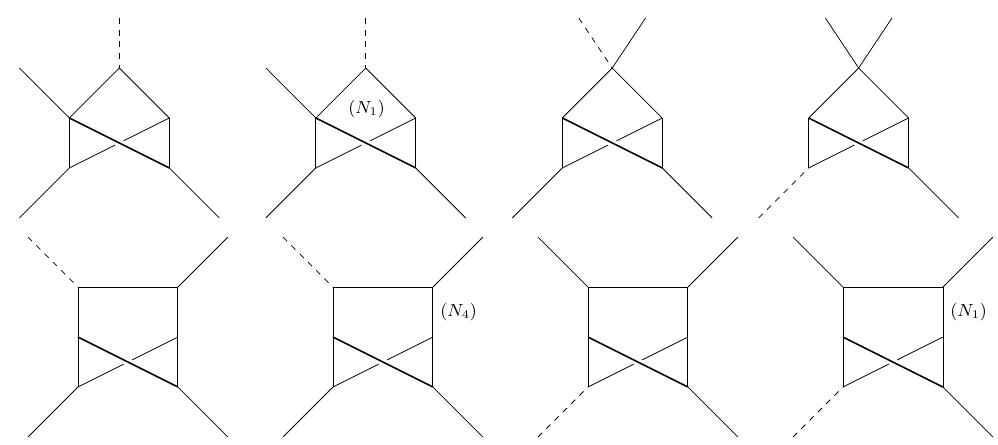
Figure 3. The non-planar topologies in the canonical